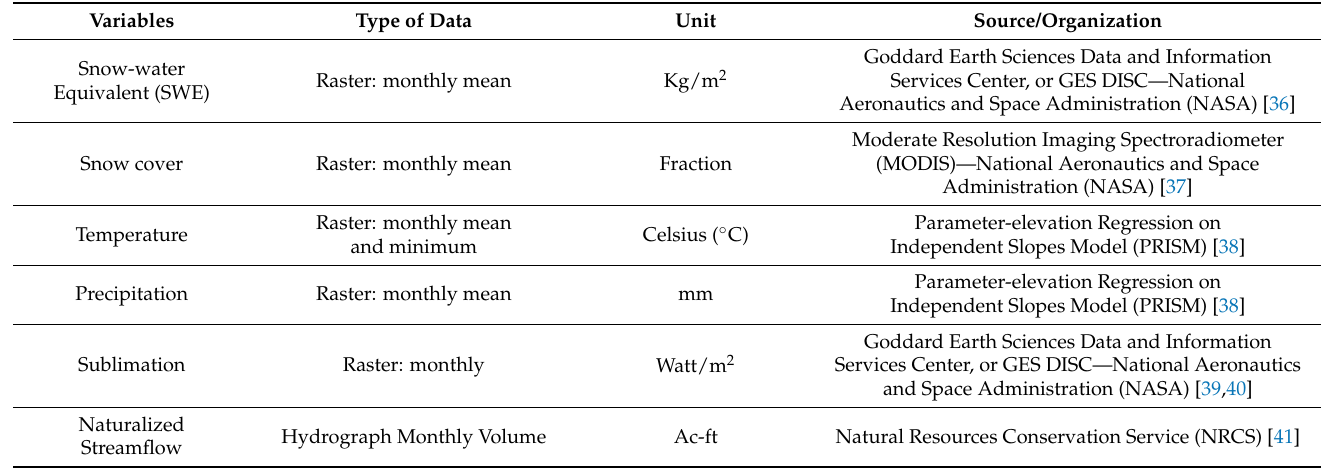
Table 2. Variables used in the study and their respective data format and